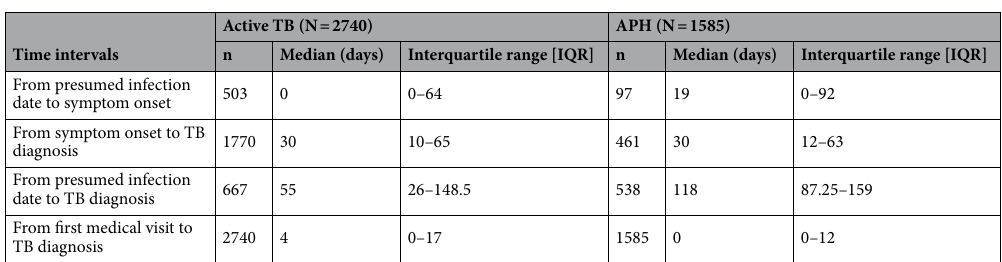
Table 4. Time from presumed infection date to symptom onset, from symptom onset to TB diagnosis, from presumed infection date to TB diagnosis, from the first medical visit to TB diagnosis by active TB and APH, Nagasaki Prefecture, 2007 to